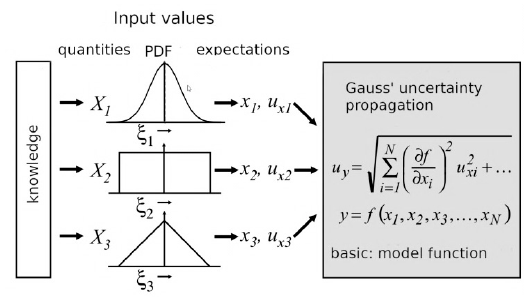
Figure 5. Classical concept to combine Type A and Type B influence parameters within GUM